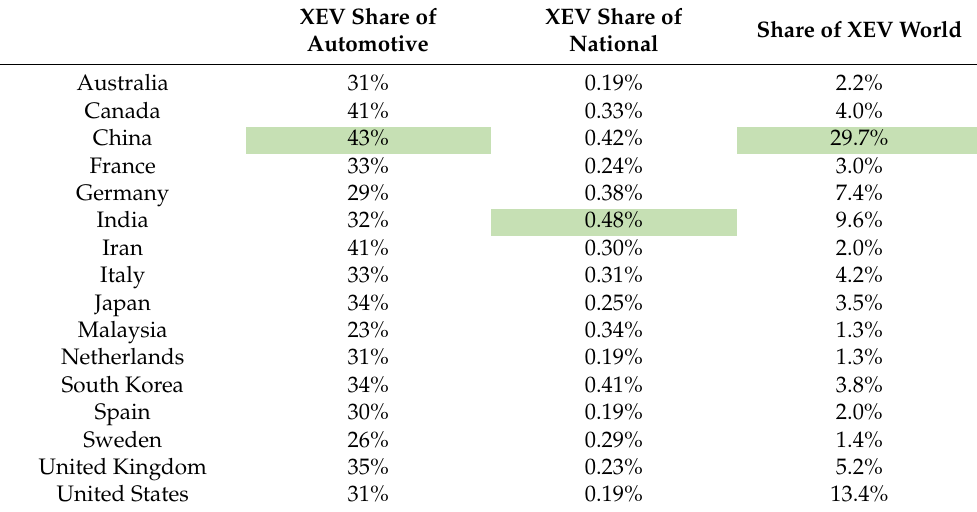
Table 2. Relative XEV publications